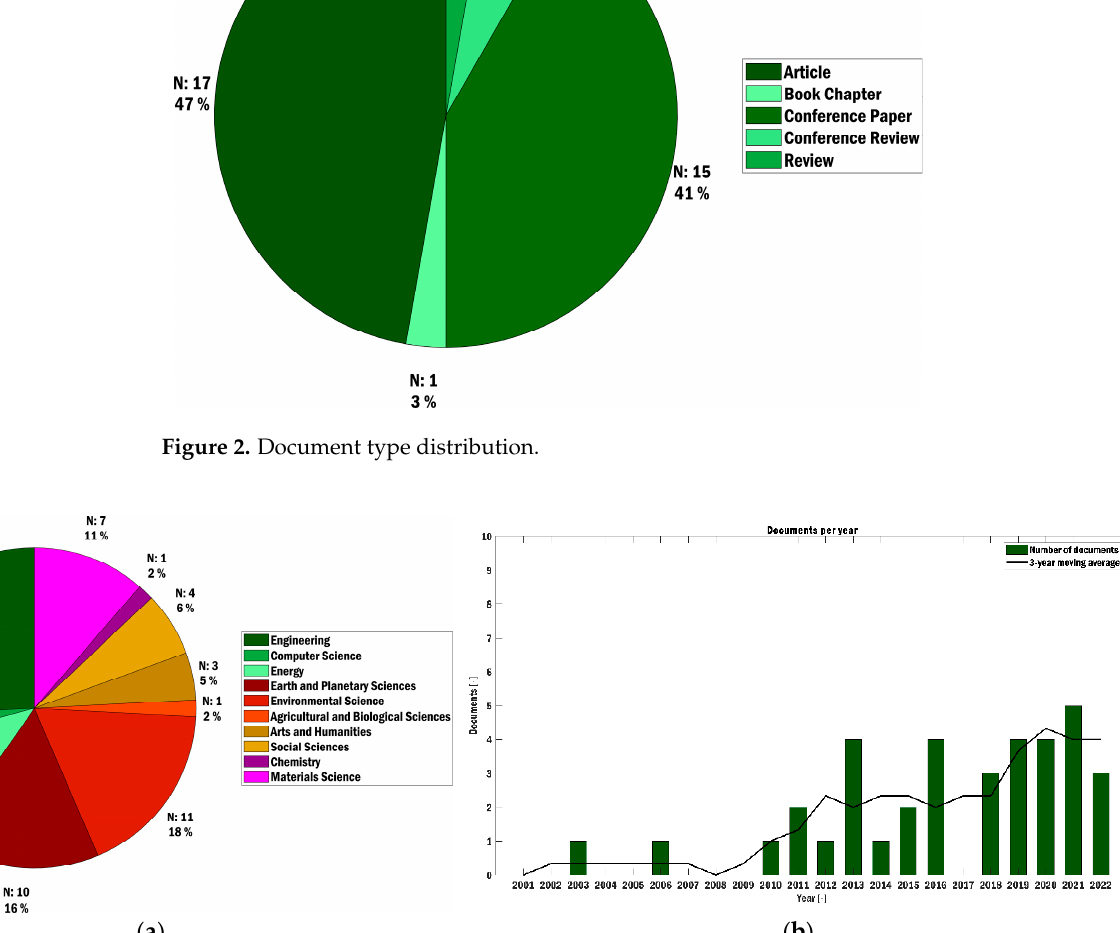
Figure 3. Results of the second query: ( a ) the distribution of documents by main subject areas; ( b ) the number of publications per year.